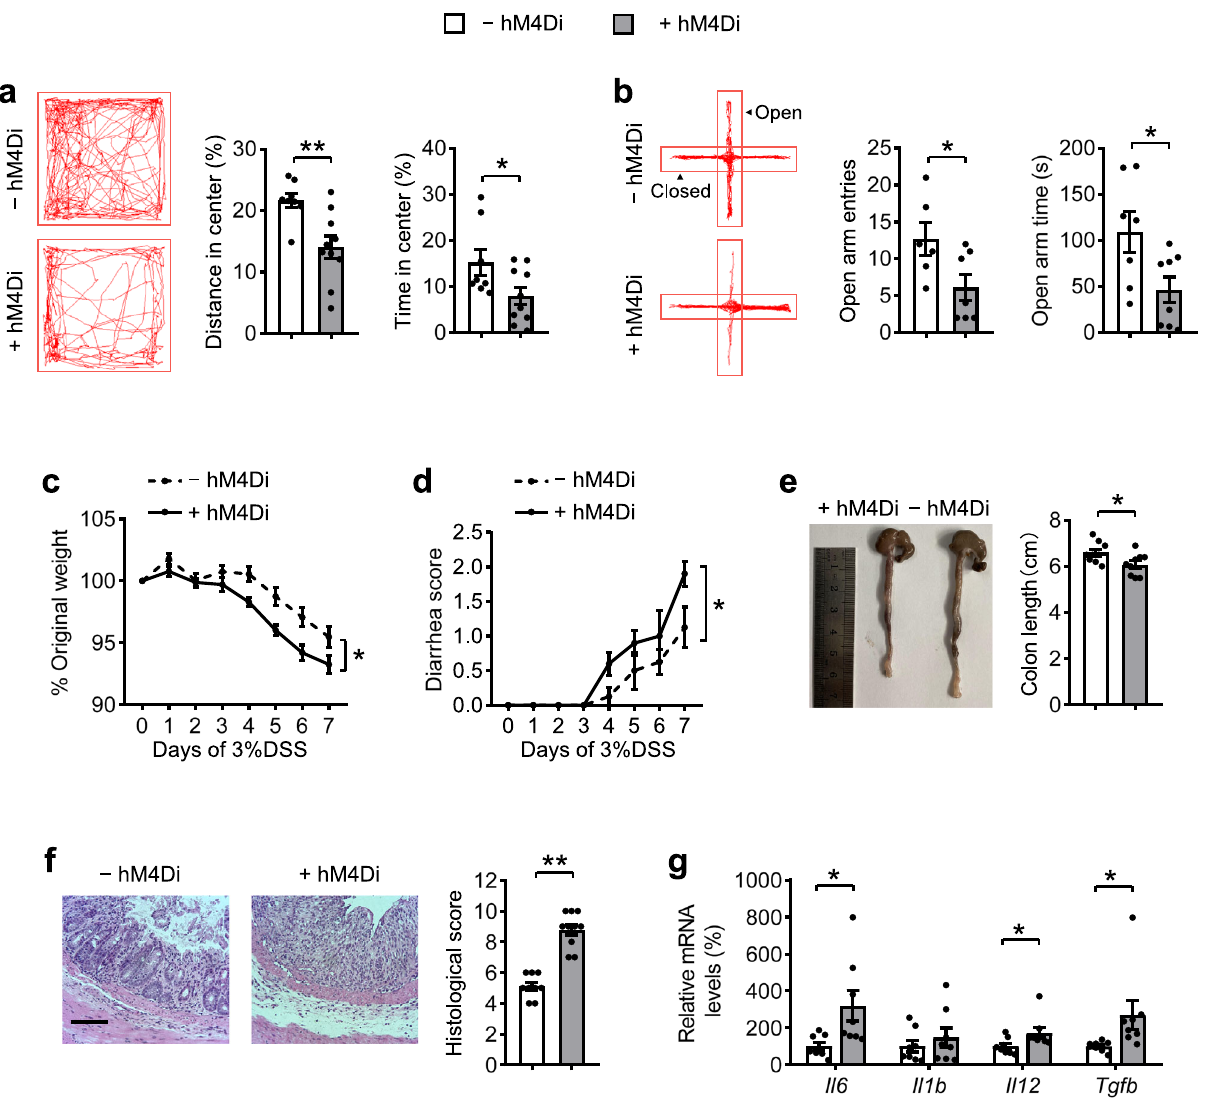
Fig. 2 Inhibition of AgRP neurons mimics CRS-increased susceptibility to anxiety and colitis. a Representative tracks and statistical results in OF test. b Representative tracks and statistics in EPM test. c Percentage of body weight loss. d Scores of diarrhea. e Gross morphology and length of the colon. f H&E staining and histological scores of the colon tissues. Scale bar, 110 μ m. g qRT-PCR analysis of mRNA expression of in fl ammatory cytokines ( Il6, Il1b, Il12 , and Tgfb ) in the distal colon tissues. Studies for a , b were conducted using 10 – 12-week-old AgRP-Cre mice receiving AAV expressing mCherry (- hM4Di) or hM4Di ( + hM4Di), all mice received CNO injections every 12 h per day. Behavioral tests were performed 30 min after single CNO injection on day 22 ( a ) and day 23 ( b ). c – g were performed using − hM4Di mice and + hM4Di mice with 3% DSS in drinking water for 7 days to induce acute colitis after 21 days of CNO injections. Values are expressed as means ± SEM ( n = 6 – 10 per group), with individual data points. Data were analyzed using two-way analysis of variance with Bonferroni ’ s multiple comparisons test ( c , d ). Data were analyzed using two-tailed unpaired Student ’ s t -test ( a , b , e – g ). * P < 0.05, ** P <